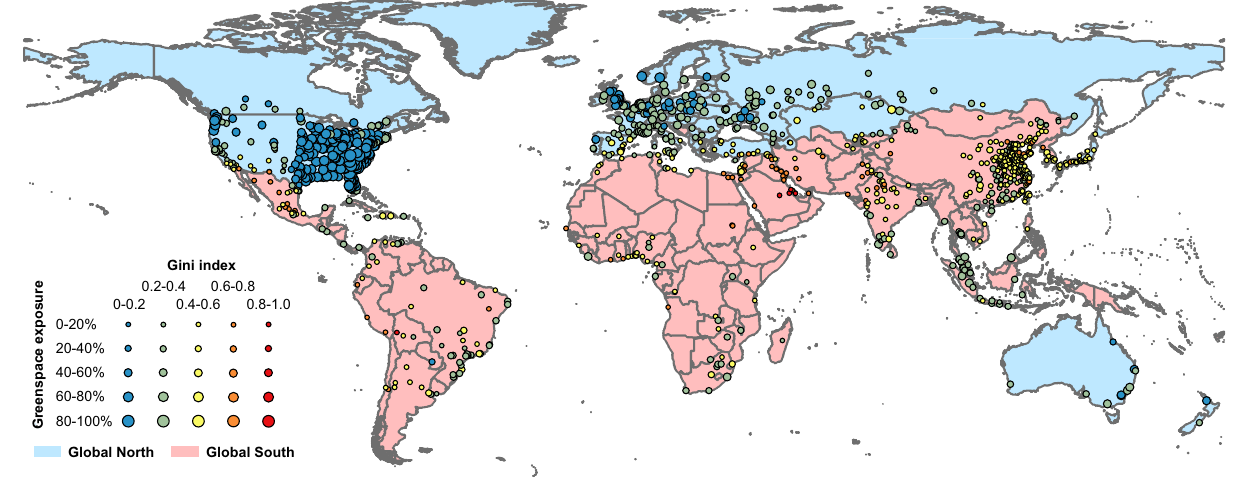
Fig. 2 | Greenspace exposure levels and the associated greenspace exposure inequalities measured by the Gini index for 1028 cities globally. Larger bubble sizesrepresenthigherlevelsofgreenspaceexposure,andwarmercolorsrepresent